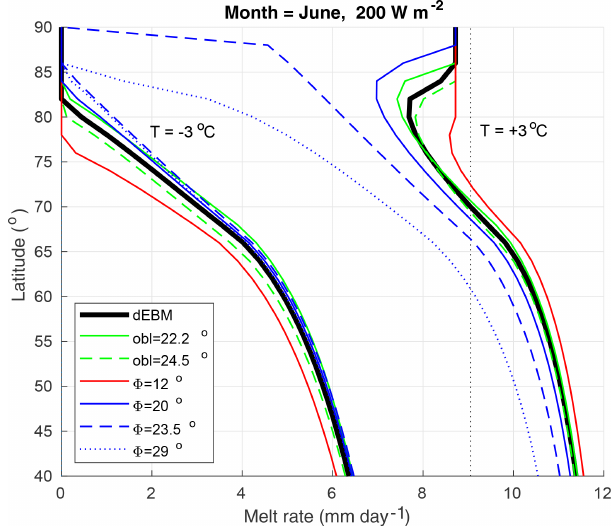
Figure 4. Sensitivity of the dEBM: June surface melt rate predicted for SW 0 = 200Wm − 2 , A = 0 . 7, T a = − 3 ◦ C (left curves) and T a = 3 ◦ C (right curves). Black is predictions with parameters used for the presented simulation of Greenland’s surface melt. Green is pa- rameters recalculated using the minimum (solid) and maximum (dashed) obliquity of the last 1 million years. Blue is parameters recalculated for minimum elevation angles (cid:56) of 20 ◦ (solid), 23 . 5 ◦ (dashed) and 29 ◦ (dots) corresponding to a reduced solar den- sity fluxes at the surface of τ b S r = 700Wm − 2 , τ b S r = 600Wm − 2 and τ b S r = 500Wm − 2 . Red is parameters recalculated for (cid:56) = 12 ◦ , which corresponds to an intensified solar density flux at the sur- face of τ b S r = 1150Wm − 2 . The dEBM const predicts 0mmday − 1 for SW 0 = 200Wm − 2 , A = 0 . 7, T a = − 3 ◦ C and 9mmday − 1 for SW 0 = 200Wm − 2 , A = 0 . 7, T a = 3 ◦ C (black dots).